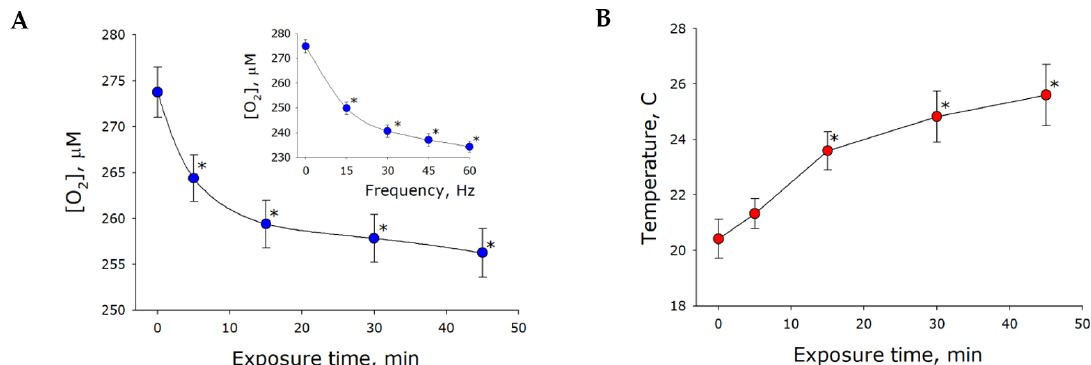
Figure 2. The e ff ect of mechanical stress (30 Hz, amplitude of 5 mm) on molecular oxygen concentration in water ( A ) and water temperature ( B ). The insert to figure ( A ) displays the e ff ect of frequency of mechanical stress on the test parameter (exposure time 5 min). The data are presented as the mean and standard error of the mean for six independent assays. Data di ff er significantly from control values (0 min) at p < 0.05